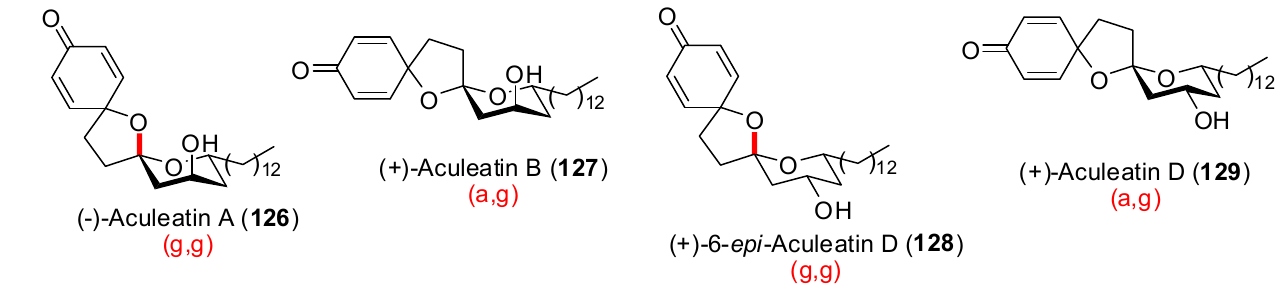
Scheme 22. Diverse members of the aculeatins